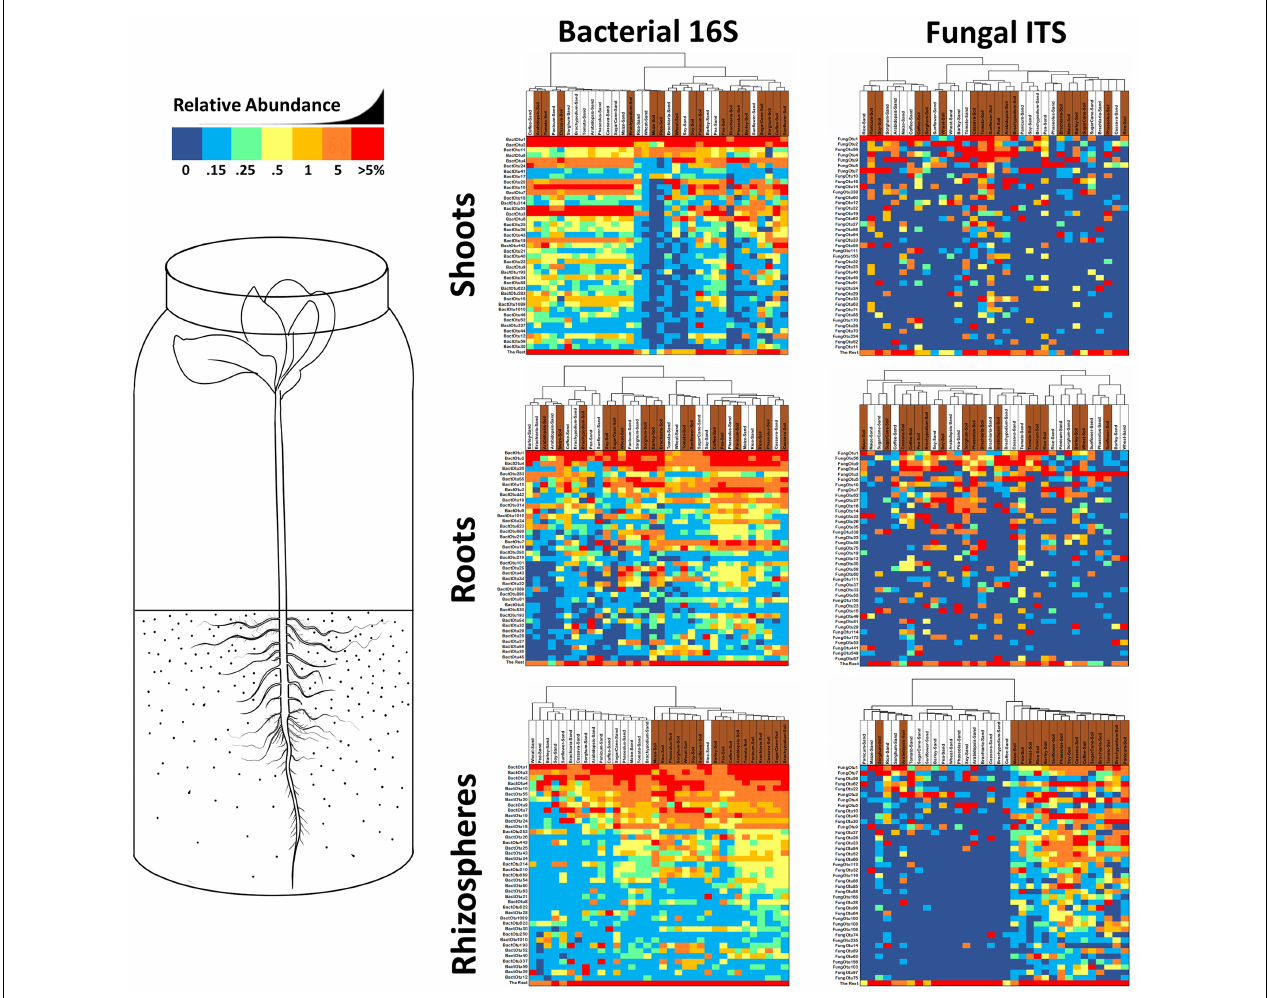
FIGURE 4 | Heatmaps of the 40 most common bacterial 16S rDNA and fungal ITS OTUs derived from Miseq analysis of rhizospheres, roots and shoots from 17 different plant species grown in sealed jars on either sterile sand or field soil. Reads were rarified for each sample (fungi—1000/roots and shoots, 2000/rhizospheres; bacteria—3000/roots, 3500/shoots, 6500/rhizospheres), averaged across repetitions, transformed into relative percentages, then clustered by Bray–Curtis dissimilarity. Samples from sand grown plants are labelled in white, samples from soil grown plants are labelled in brown. Cells are shaded by percentage value with 0% being dark blue, up to 0.1% being light blue, between 0.1–0.25% being green, 0.25–0.5% being light yellow, 0.5-1% being dark yellow, 1-5% being orange and greater than 5% being